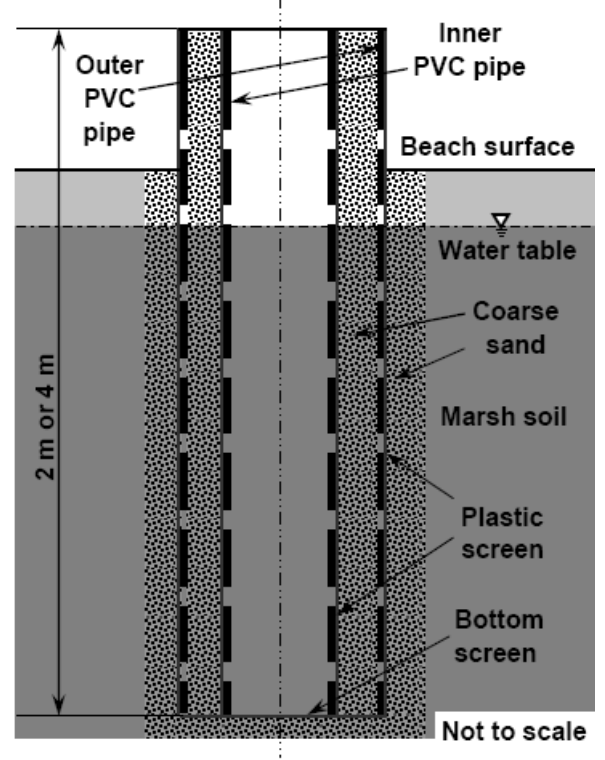
Fig. 3. Installation details of the observation wells.